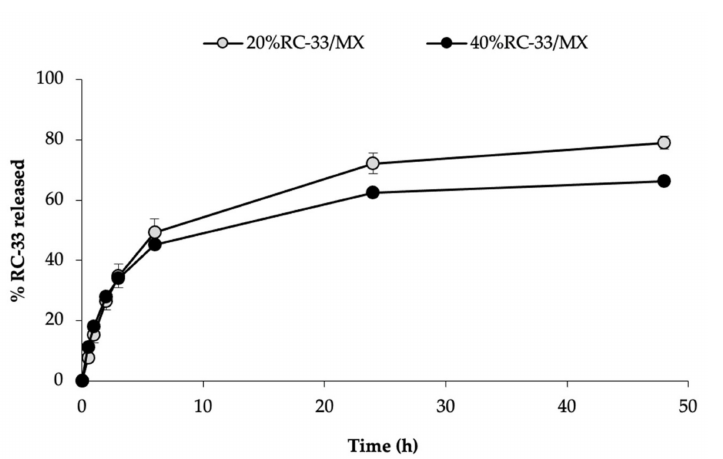
Figure 10. RC-33 release profiles of matrices loaded with RC-33 amounts corresponding to 20 and 40% of the GG interaction sites (respectively, 20%RC-33/MX and 40%RC-33/MX) (mean values ± s.e.; n =